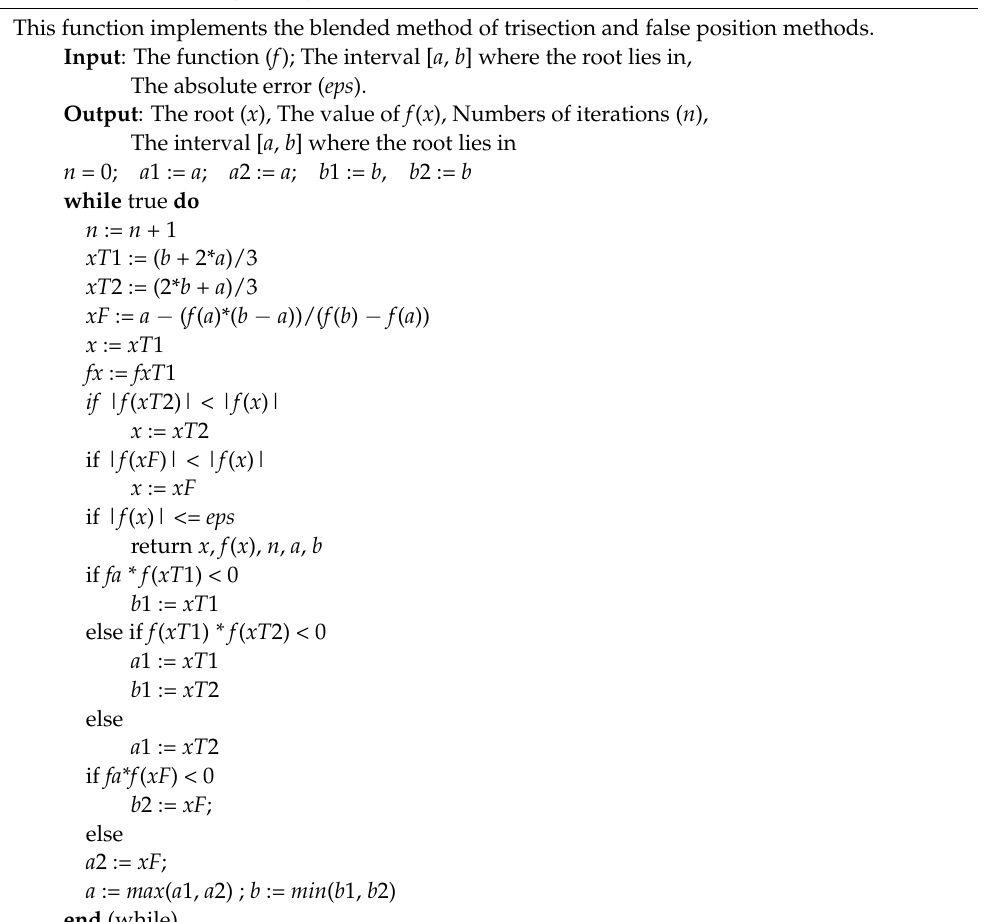
Algorithm 7. blendTF( f , a , b , eps